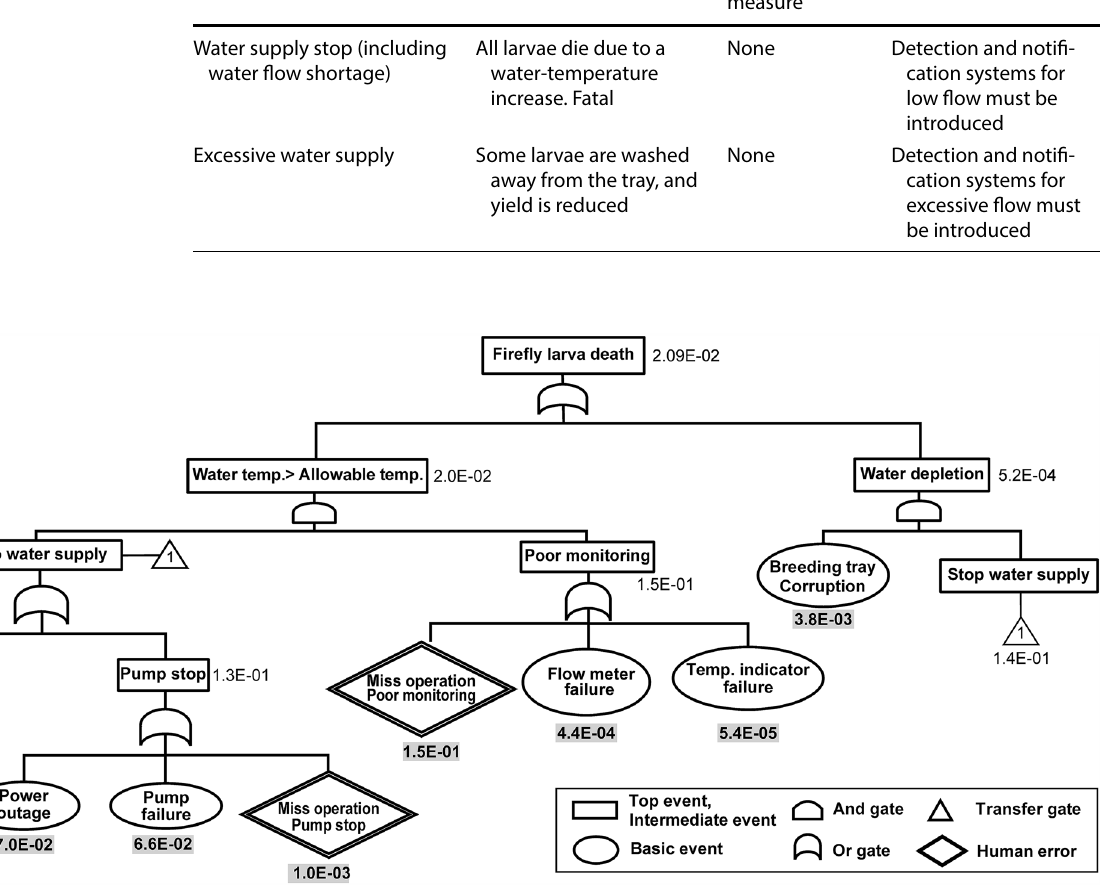
Table 2 What-If results What-If